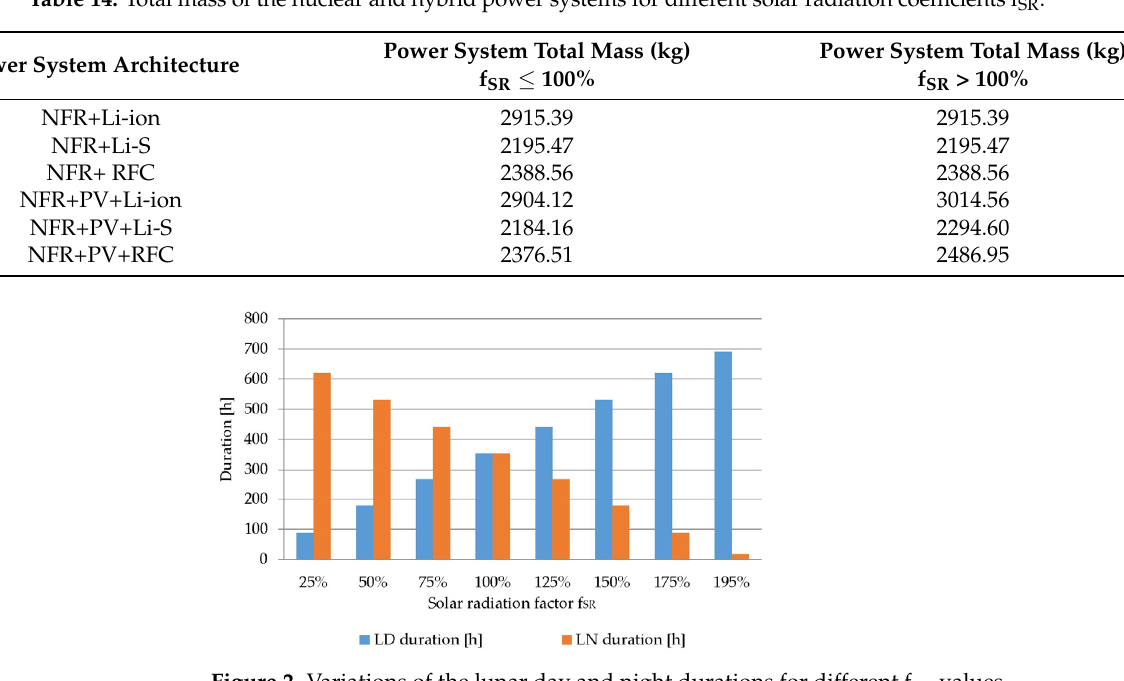
Table 14. Total mass of the nuclear and hybrid power systems for different solar radiation coefficients f SR .